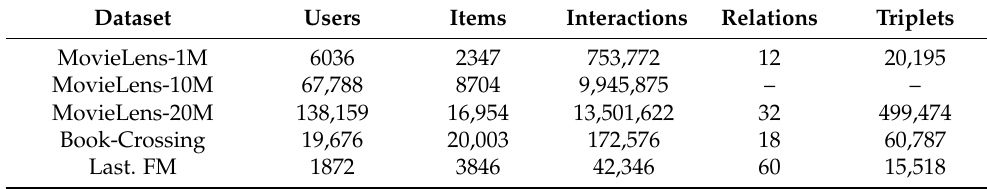
Table 1. Statistics of the